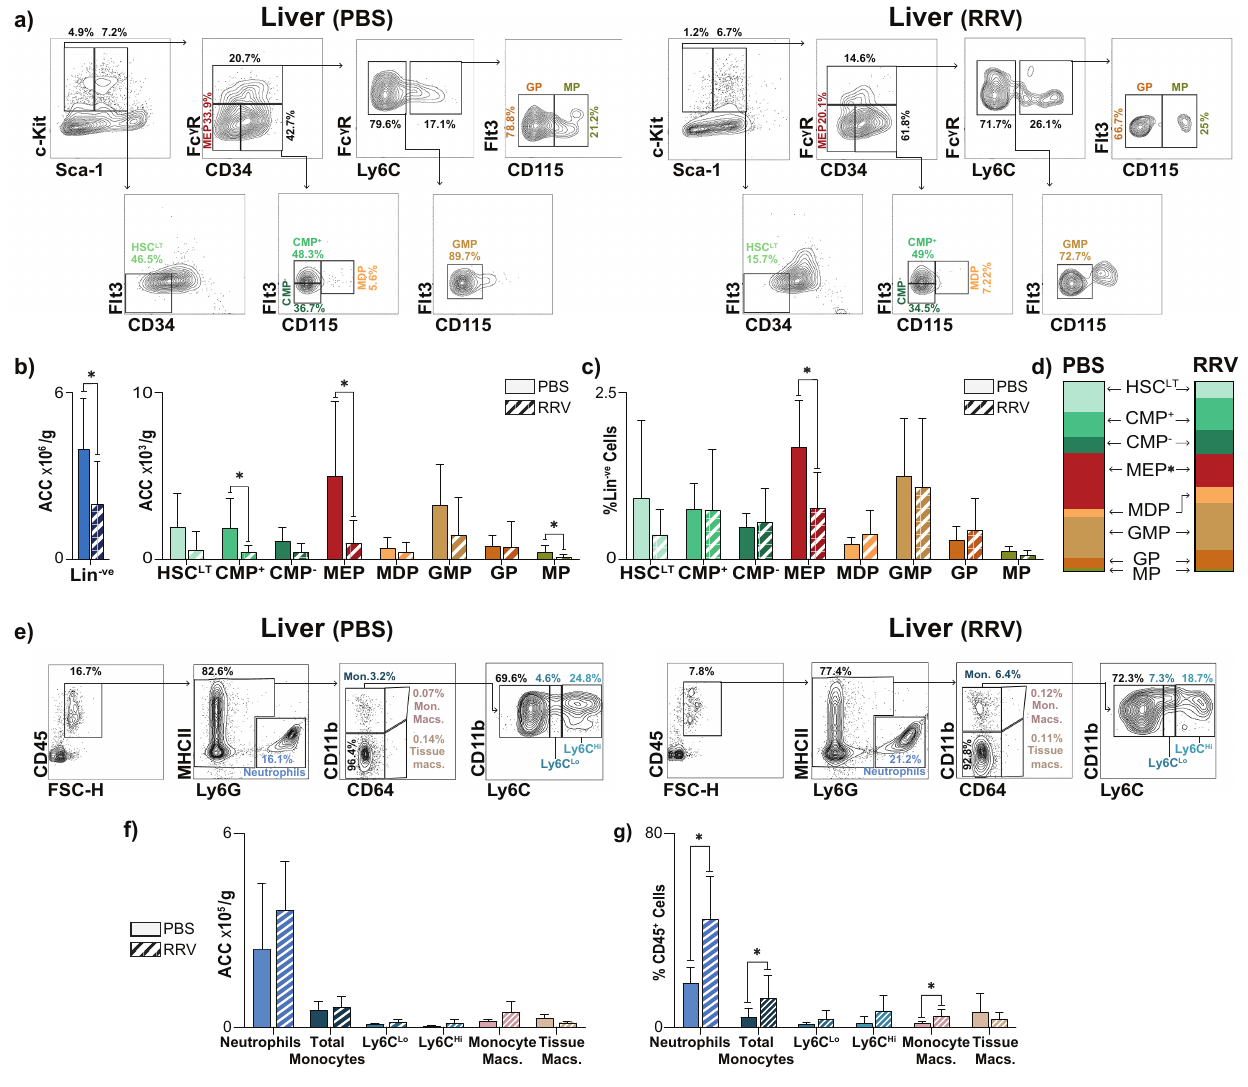
Total MonocytesLy6C Lo Ly6C Hi Monocyte Tissue Macs.Neutrophils Macs. Figure 5. Perinatal liver injury leads to contraction of hematopoietic progenitors and expansion of mature myeloid cell proportions in the juvenile liver. (a) Representative flow plots demonstrating gating strategy of hematopoietic stem cells (HSC LT ), common myeloid progenitors (CMP), and terminal myeloid progenitors (TMP) in liver of PBS- and RRV-injected 14-day-old (P14) mice (b) Absolute cell count (ACC) of lineage negative (Lin -ve ) cells, hematopoietic stem cells (HSC LT ), common myeloid progenitors (CMPs), and terminal myeloid progenitors (TMPs) of the liver, (c) percentage of total Lin-ve cells, and (d) fraction of whole for HSC LT , CMPs, and TMPs. (e) Representative flow plots demonstrating gating strategy of mature myeloid CD45 + populations in liver of PBS- and RRV-injected 14-day-old (P14) mice. (f) ACC of mature myeloid populations (PBS n=3, RRV n=3) of the liver and (g) percentage of individual mature myeloid populations out of all CD45 + cells (PBS n=5, RRV n=9) at post-natal day 14 (P14). n=6 for PBS and n=8 for RRV unless otherwise stated. p-value *<0.05. Error bars represent mean ± SD.